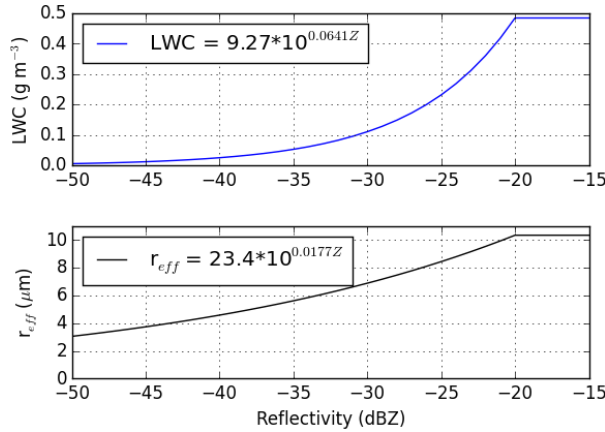
Figure 2. Empirical relationships between radar reflectivity ( Z ) and LWC and effective radius used in this study, based on Fox and Illingworth